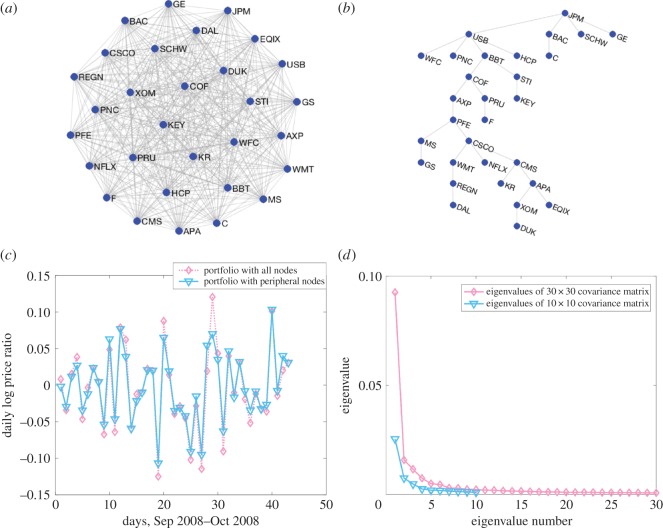
Portfolio selection based on the MST. (a) The complete graph and (b) the corresponding MST constructed from the 30 selected S&P 500 stocks during the period September 2008 to October 2008. (c) The performance of the portfolio of 10 randomly selected vertices from the 14 leaves shown in b. (d) The eigenvalue spectrum of the covariance matrix of the 30 selected S&P 500 stocks in a with that of 10 stocks randomly chosen from the peripheral nodes from the MST in c.